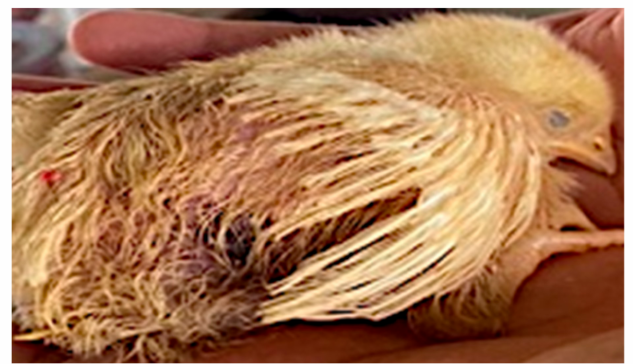
Figure 1. Broiler with growth retardation in